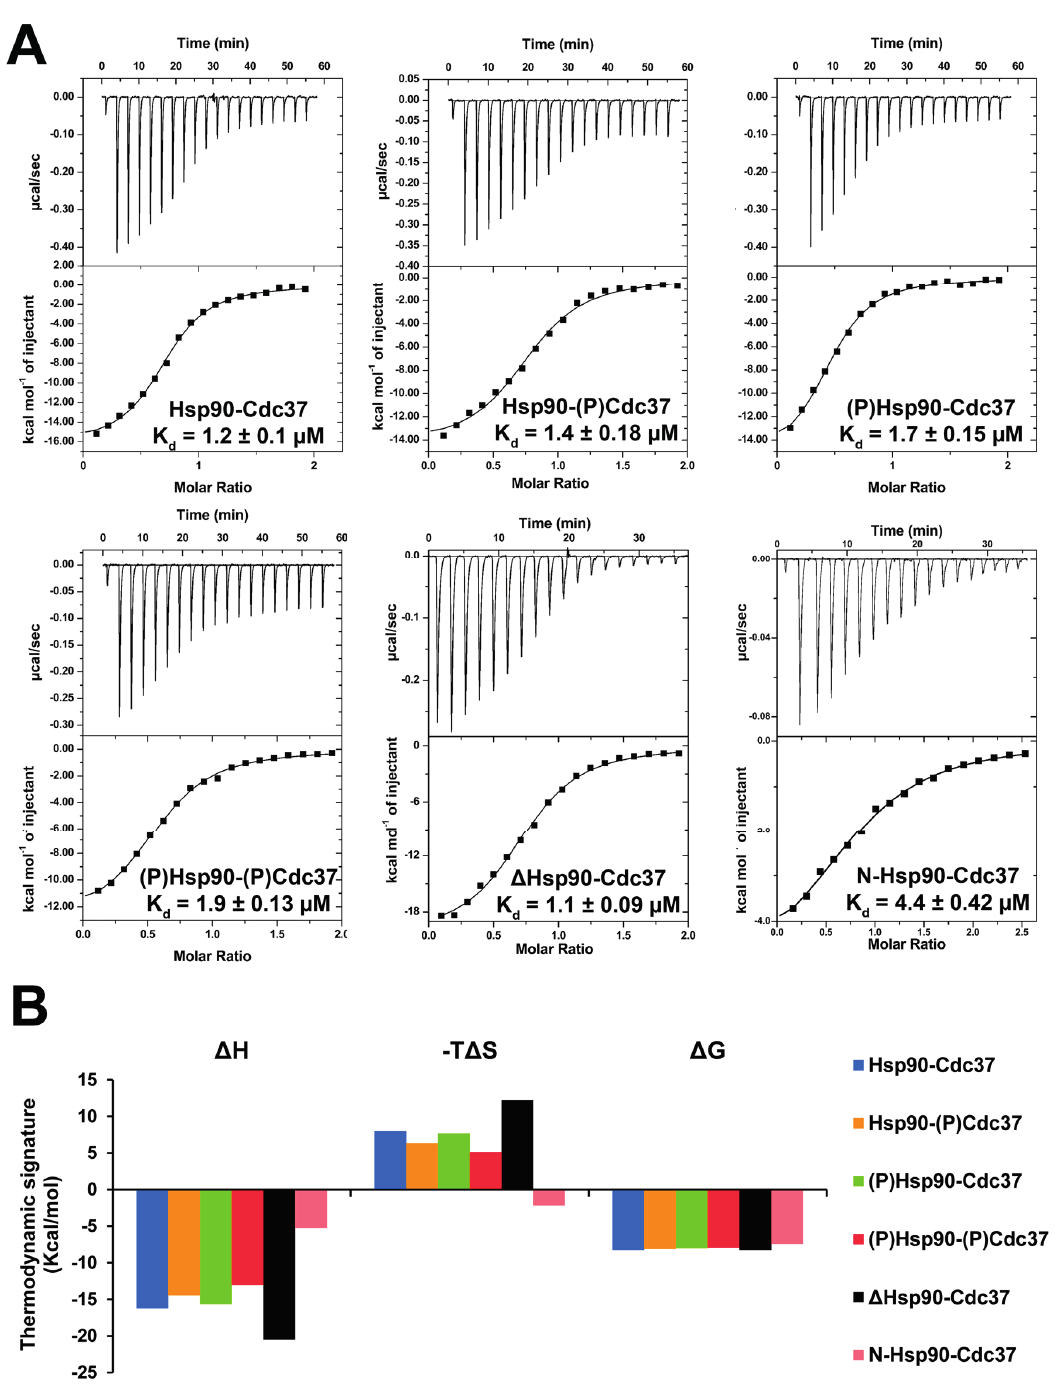
Figure 2. Influence of phosphorylation by CK2 on the thermodynamics of Hsp90 β -p50 Cdc37 complex formation. ( A ) Isothermal titration calorimetry (ITC) experiments of the Hsp90 β -p50 Cdc37 complex formation using unphosphorylated and phosphorylated proteins. The last two graphs show the interactions of Hsp90 without the acidic loop ( Δ Hsp90) and of the N-terminal domain (N-Hsp90); ( B ) Thermodynamic signatures of the protein–protein interactions